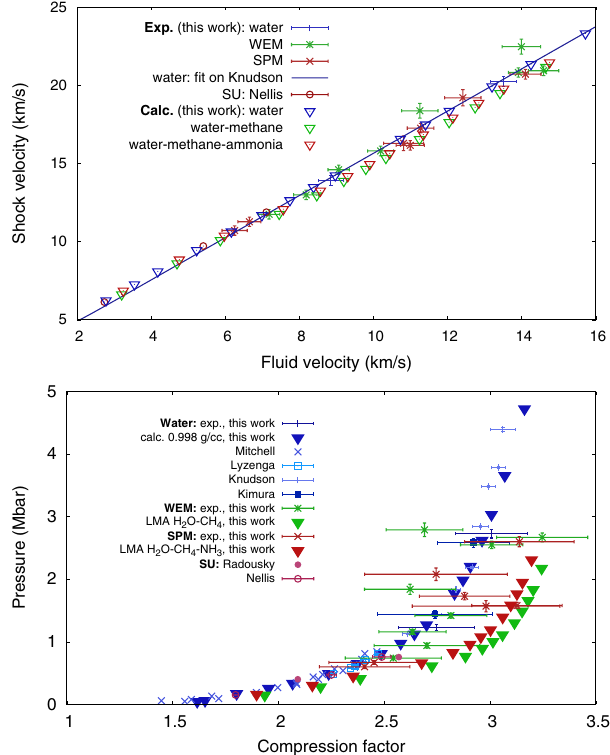
Figure 2. Top. Experimental shock - fluid velocity data on water, WEM, and SPM (blue, green, and red points with error bars, respectively) compared to DFT-MD calculations (triangles). A linear fit on previous water data 26 and previous experimental data on synthetic Uranus 22 (similar to the SPM) are shown for comparison. Bottom. Transposition in the pressure - compression factor ( ρ / ρ 0 ) plane of the data displayed on the top image. Other previous data on water 23,24,27 and on synthetic Uranus 21 are